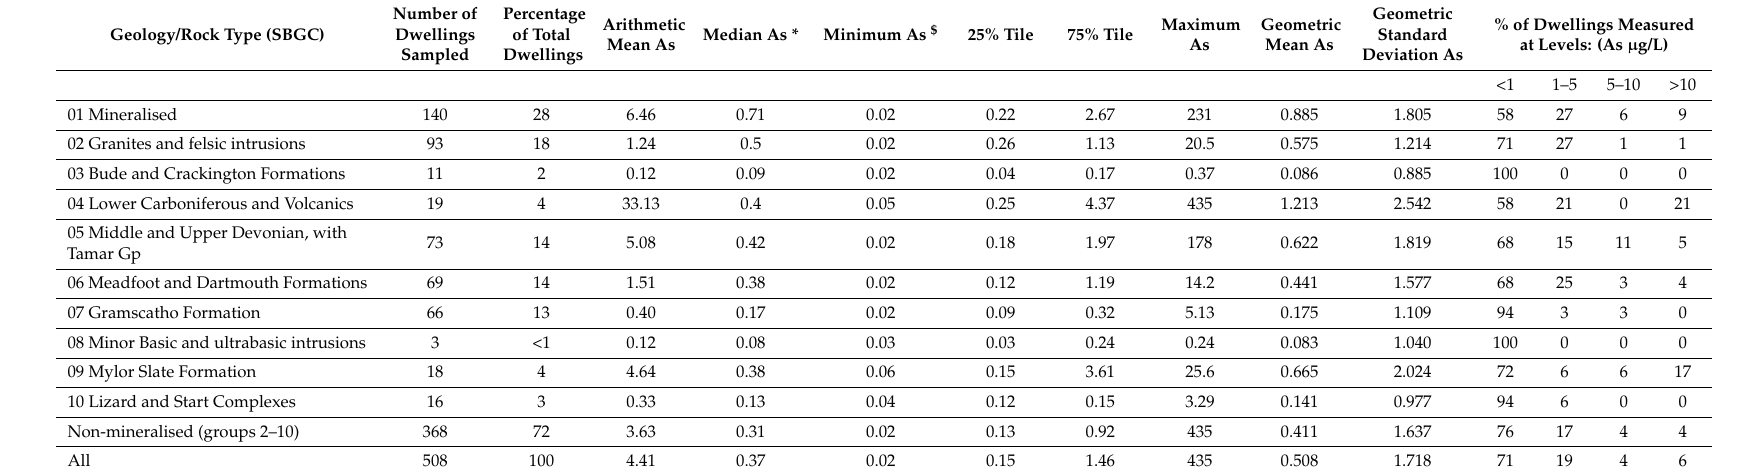
Table 1. Descriptive statistics of arsenic concentrations ( µ g/L) in Private Water Supplies (PWS) in dwellings classified by Simplified Bedrock Geological Category (SBGC) measured in Cornwall,